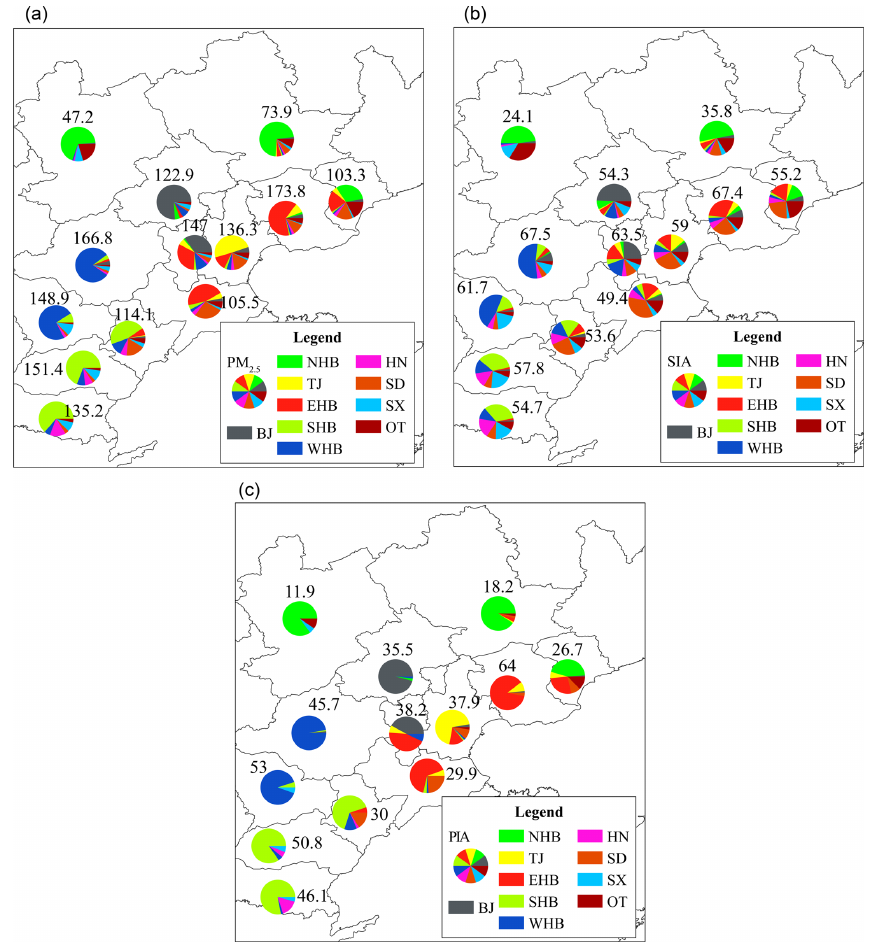
Figure 6. The contribution of regional transport and local emissions to the average (a) total PM 2 . 5 ; (b) secondary inorganic aerosol (SIA); and (c) primary inorganic aerosol (PIA), including BC and primary inorganic PM 2 . 5 , over the BTH area. The numbers above the pie charts represent average concentrations (µgm − 3 ) of certain species in certain